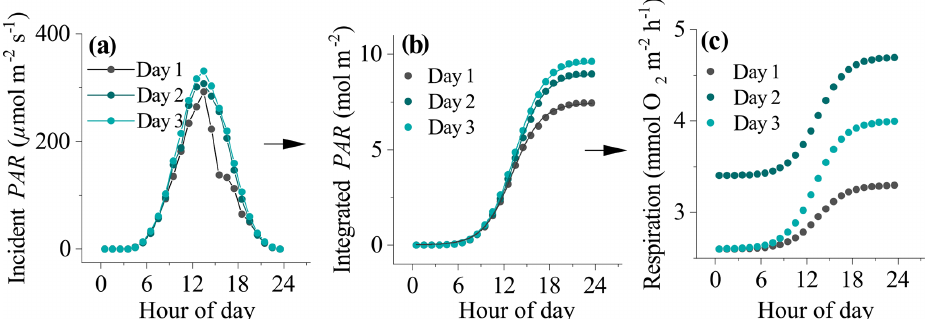
Figure 1. The process used to derive daytime respiration rates for datasets impacted by hysteresis. (a) Incident seabed PAR, (b) integrated PAR, and (c) estimated hourly respiration rates. The line of best fit to the data in (b) is a Boltzmann function ( R 2 > 0 . 99). The fitting parameters were used to determine the shape of the respiration curve in (c) from night-time flux periods | J N1 | to | J N2 | (see text).